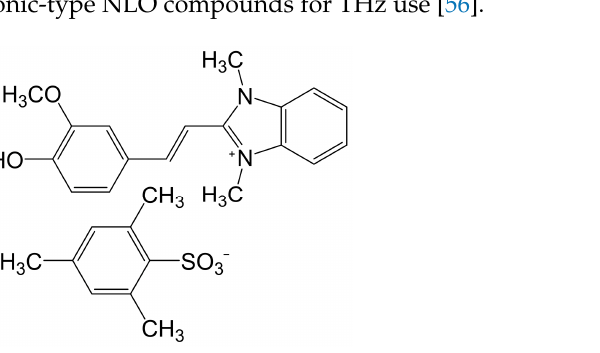
Figure 16. Chemical structure of benzimidazolium-based HMI-TMS.